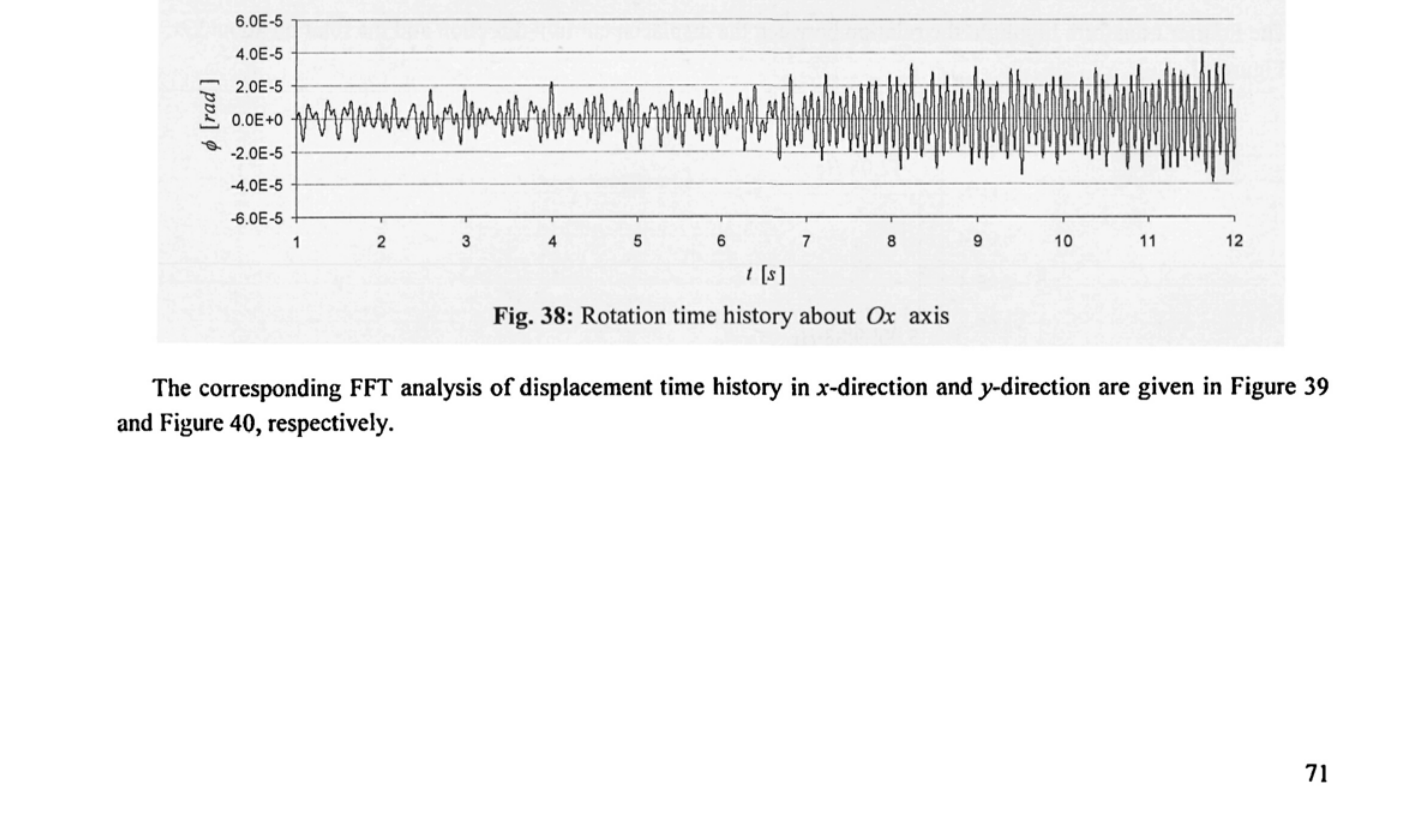
Fig. 37: Displacement time history in ^-direction